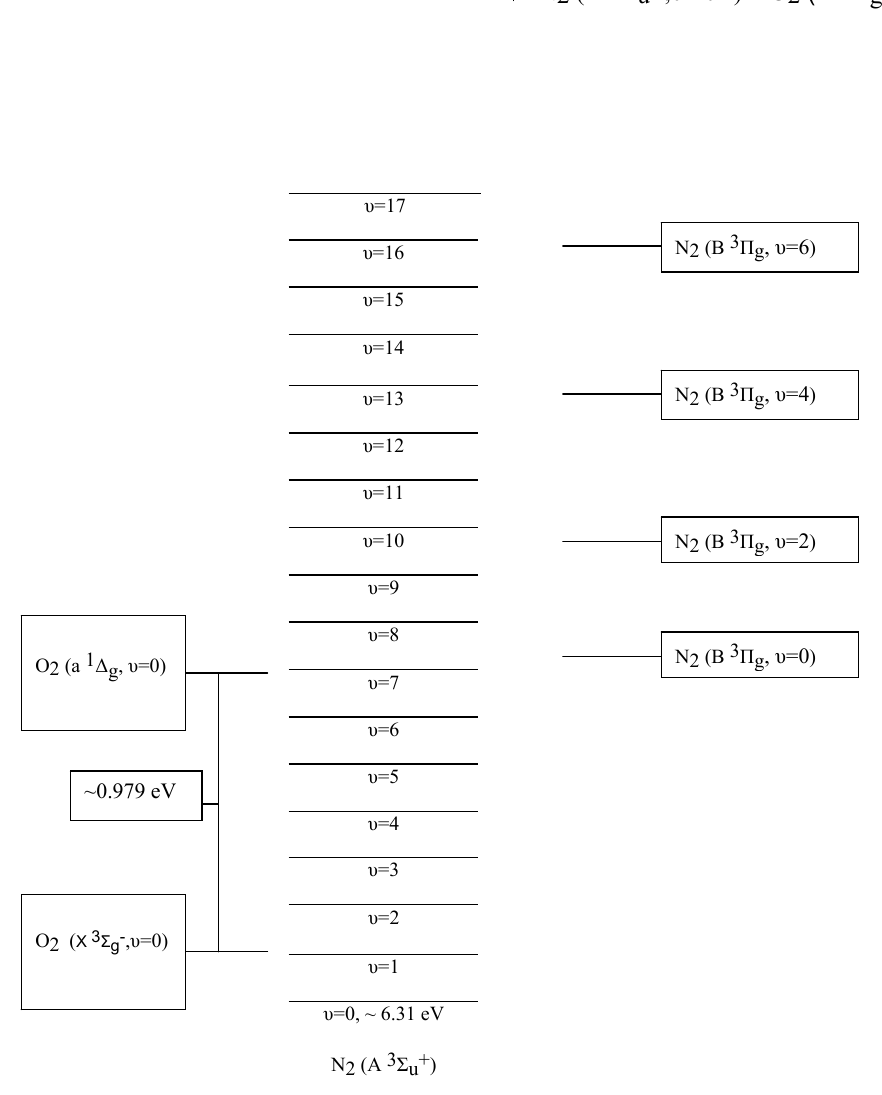
Fig. 1 A schematic diagram of vibrational energy levels of the first excited –metastable- electronic N 2 state, N 2 (A Σ + ), that is energy rich ( ∼ 6,31 eV over the ground state energy for υ =0), and u of the higher N 2 (B 3 Π g ) electronic state, and of the potential energy difference between the first excited –metastable- electronic O 2 state, O 2 (a 1 ∆ g , υ =0), and the ground electronic O 2 state, O 2 (X 3 Σ − , υ =0), with the same energy scale. The 3 reactions considered in this work are shown g on the top of the